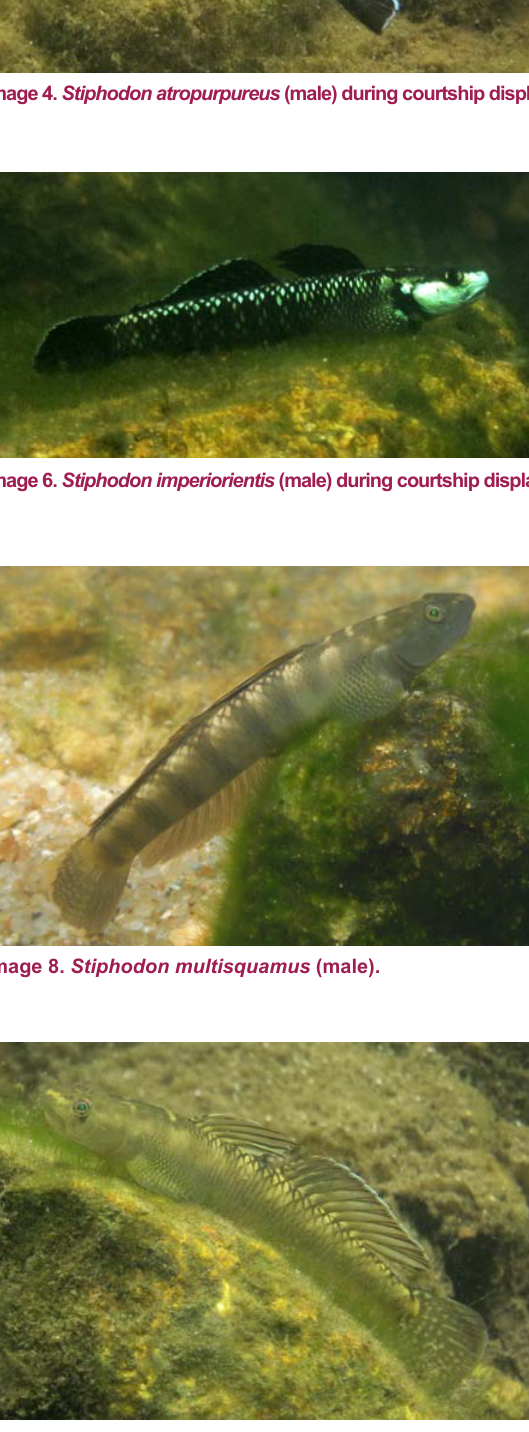
Image 9 Stiphodon multisquamus (male) showing darker colour with a slight bluish tinge.